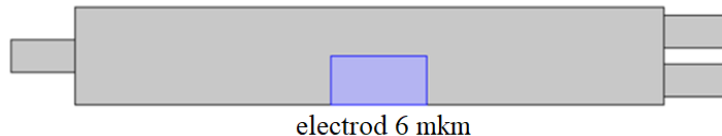
Fig. 5. Model of multimode interference divider with an electrode of 6 μm in length .